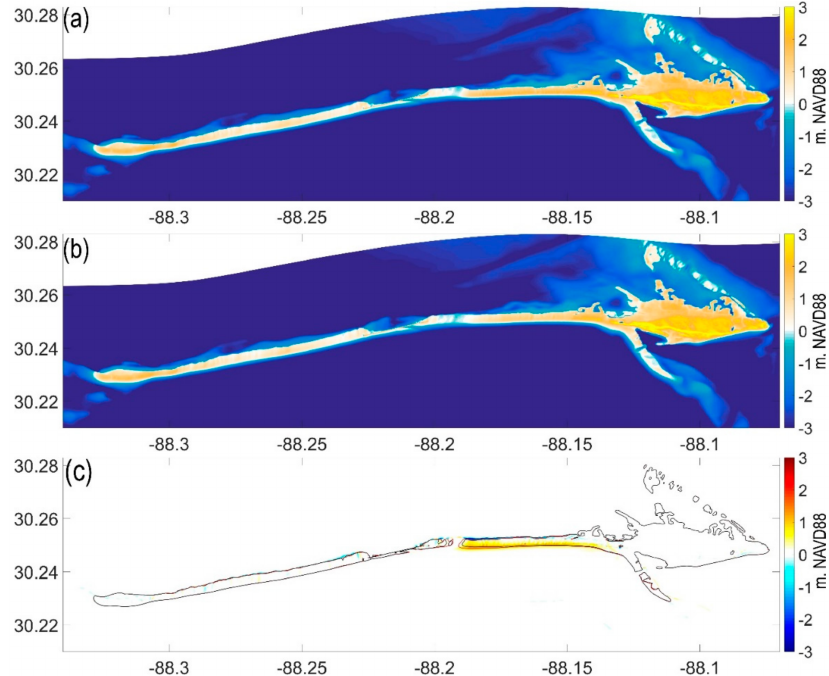
Figure 6. Post-storm 152 bed level elevations for the ( a ) nourishment scenario, ( b ) no-action scenario and ( c ) difference between nourishment and no-action scenarios. In ( c ), the black line is the 0 m contour for final (Year 30) no-action scenario and the red line is the 0 m contour for the final (Year 30) nourishment